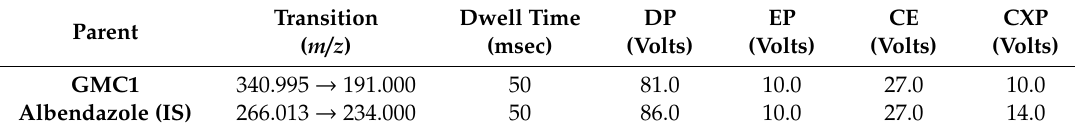
Table 7. Compound specific parameters for MS / MS acquisition of GMC1 and IS (albendazole).